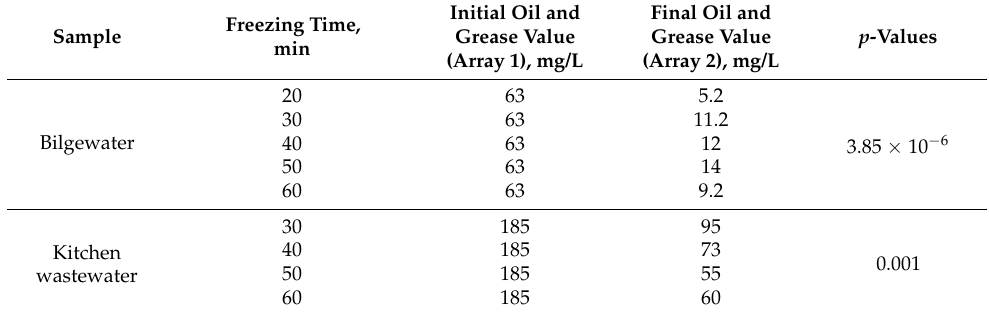
Table 4. Initial and final oil and grease values at different freezing time and p -values obtained. Sample